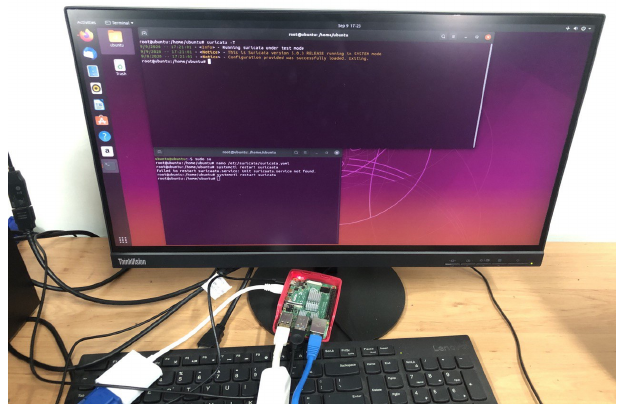
Figure 15. Deployment of SUKRY.